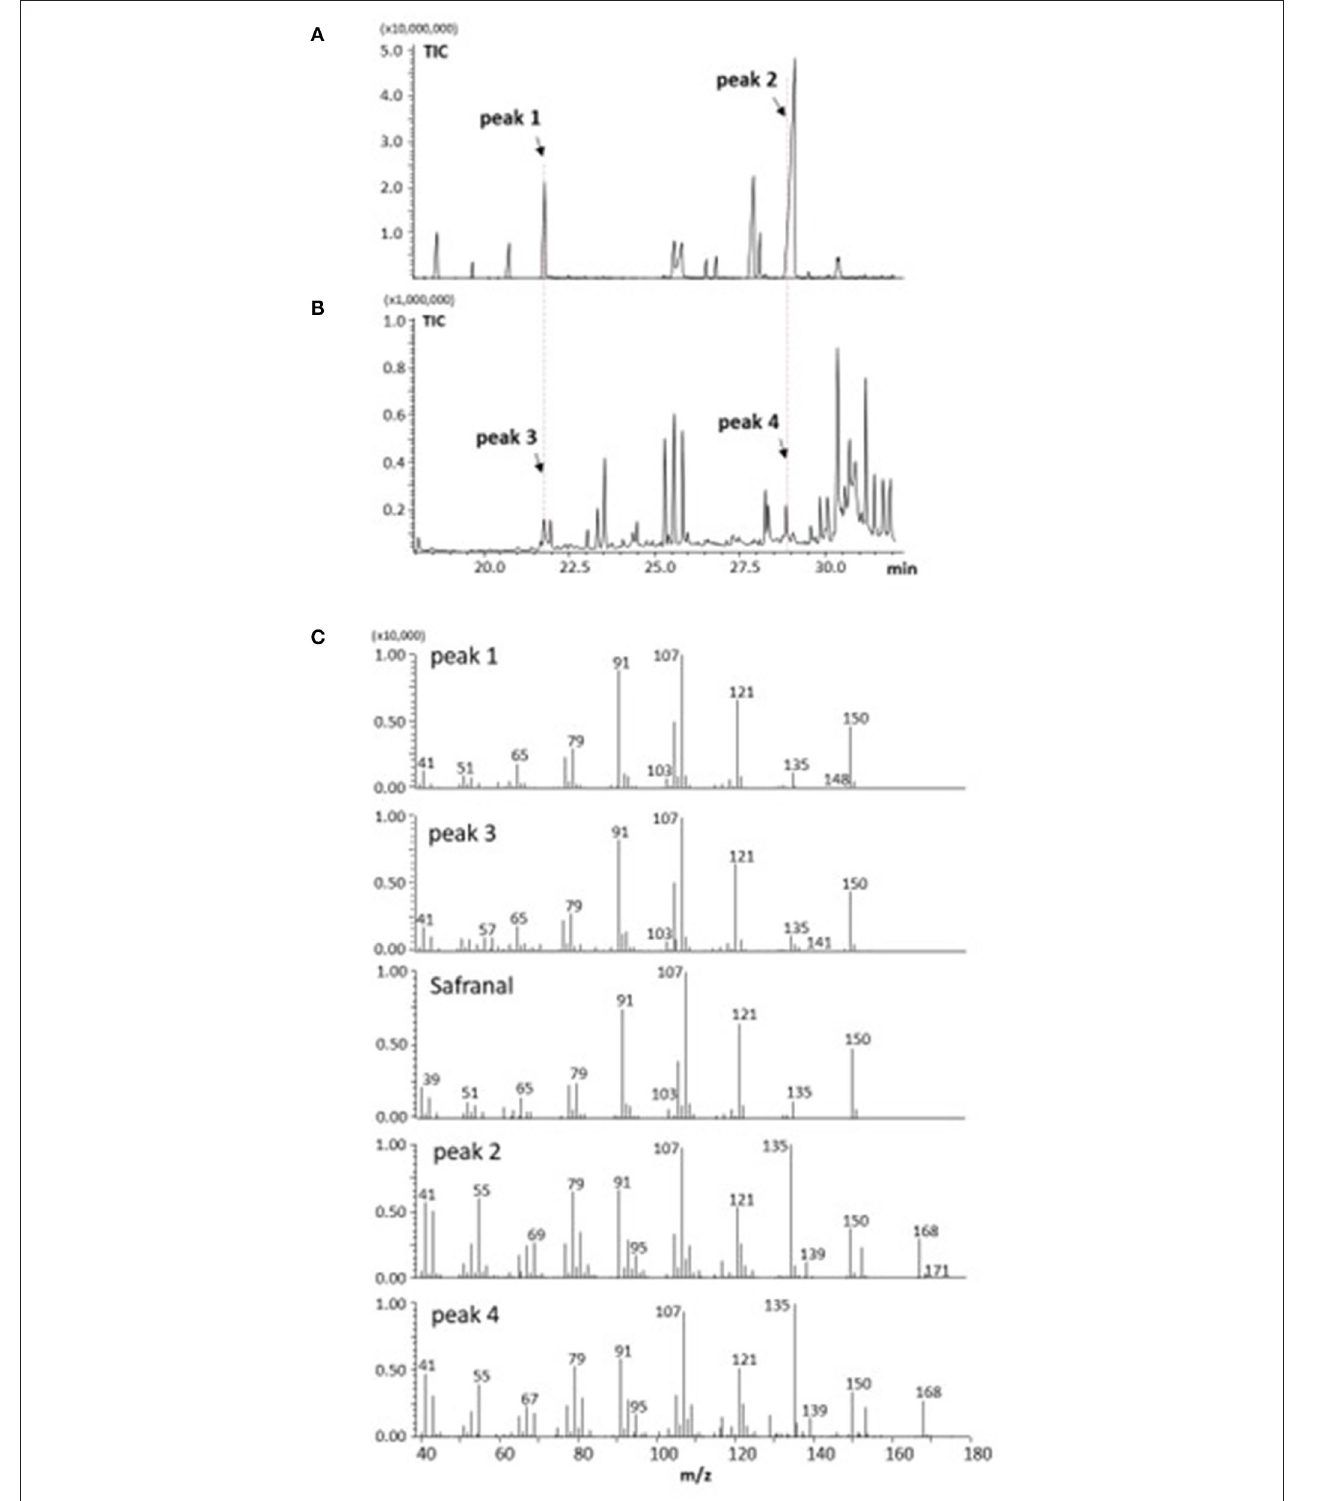
FIGURE 3 | GC-MS analysis of volatile components from saffron (A,C) and freesia “f2” yellow-flowers (B,C) .